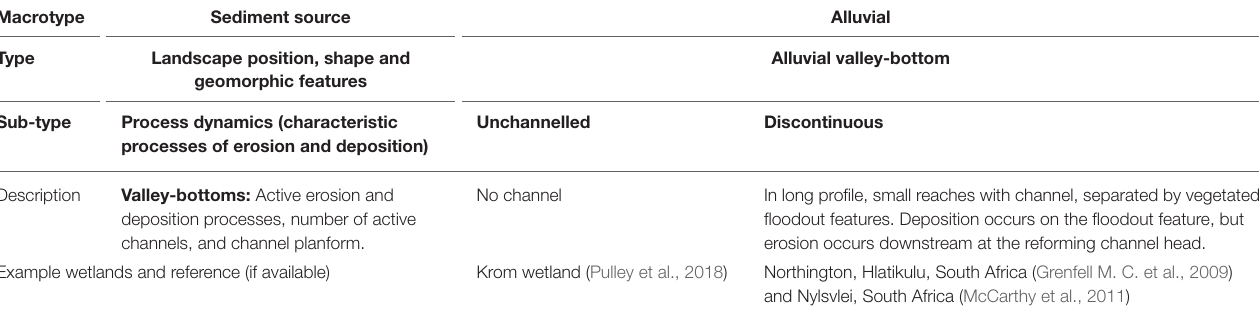
TABLE 4 | Description of valley-bottom